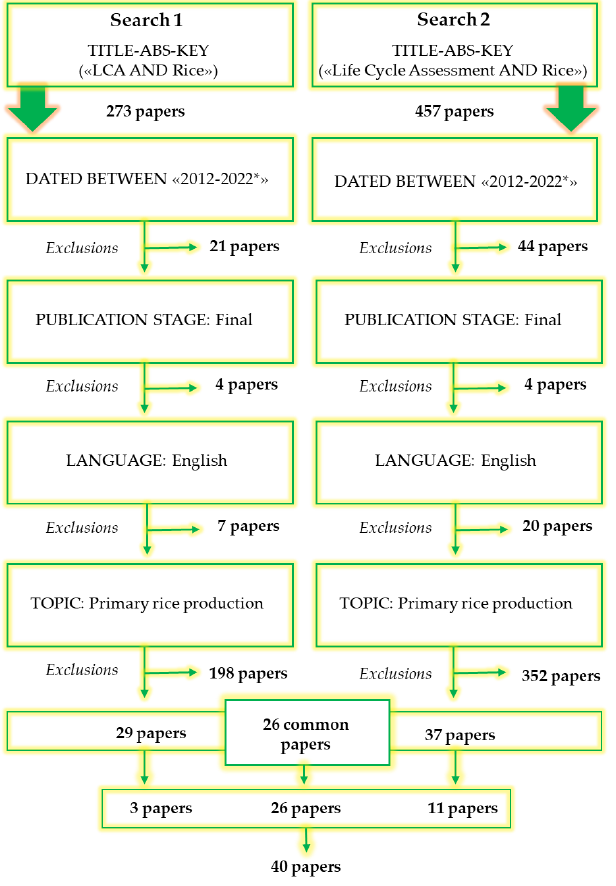
Figure 1. Stages of selecting articles for the literature review (* November 2022).